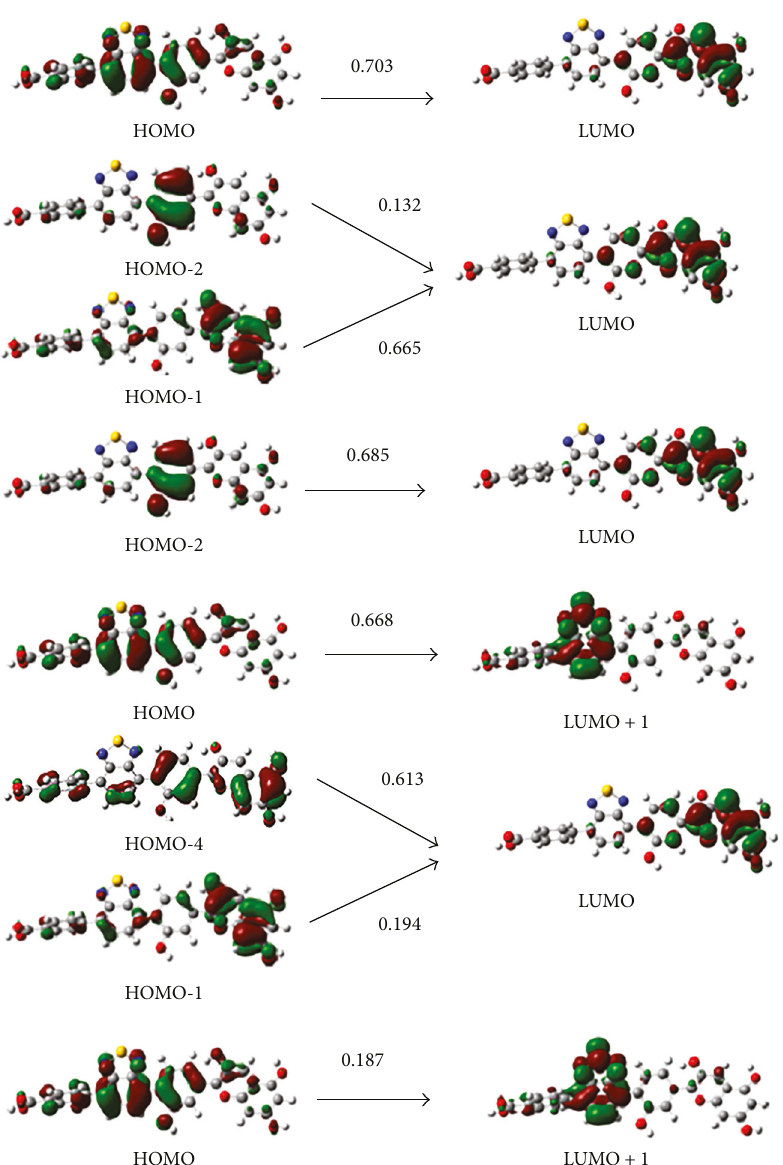
Figure 3: The behavior of electron density clouds at the various energy levels corresponding to the fi rst fi ve excited states of P01-1 in ethanol using the TDDFT simulation with isovalue of